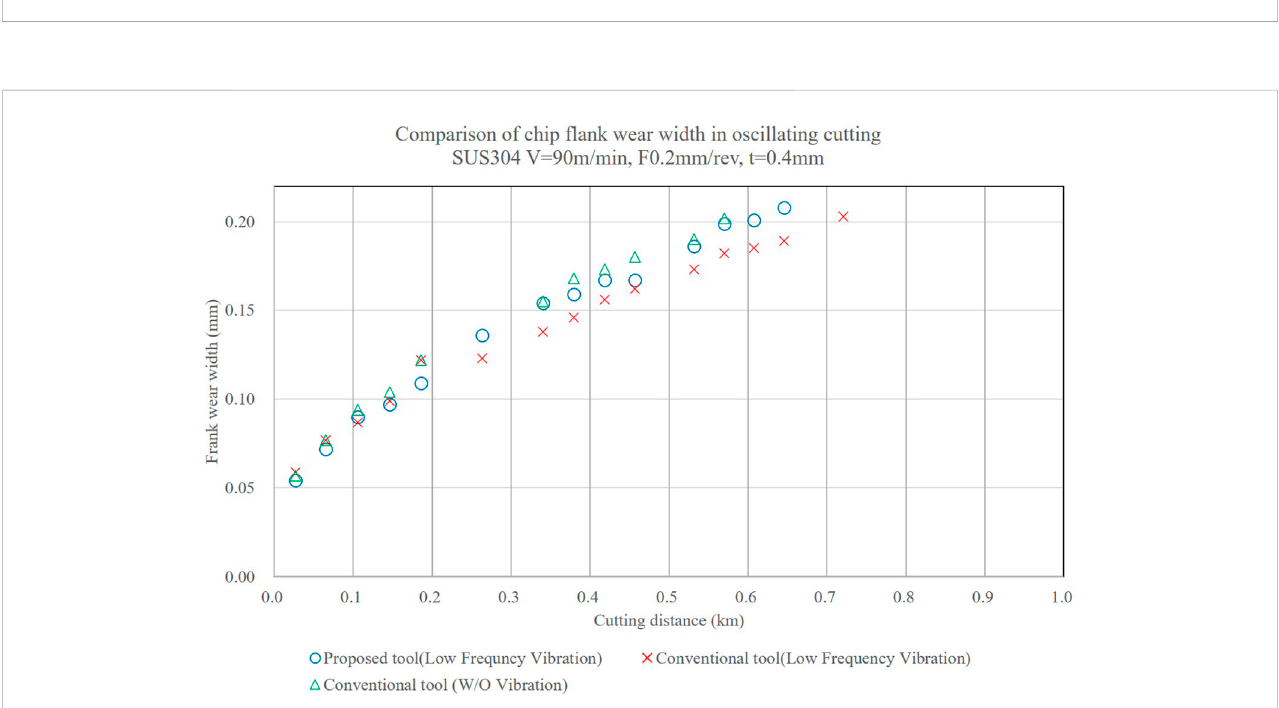
FIGURE 15 Comparison of chip fl ank wear width in oscillating